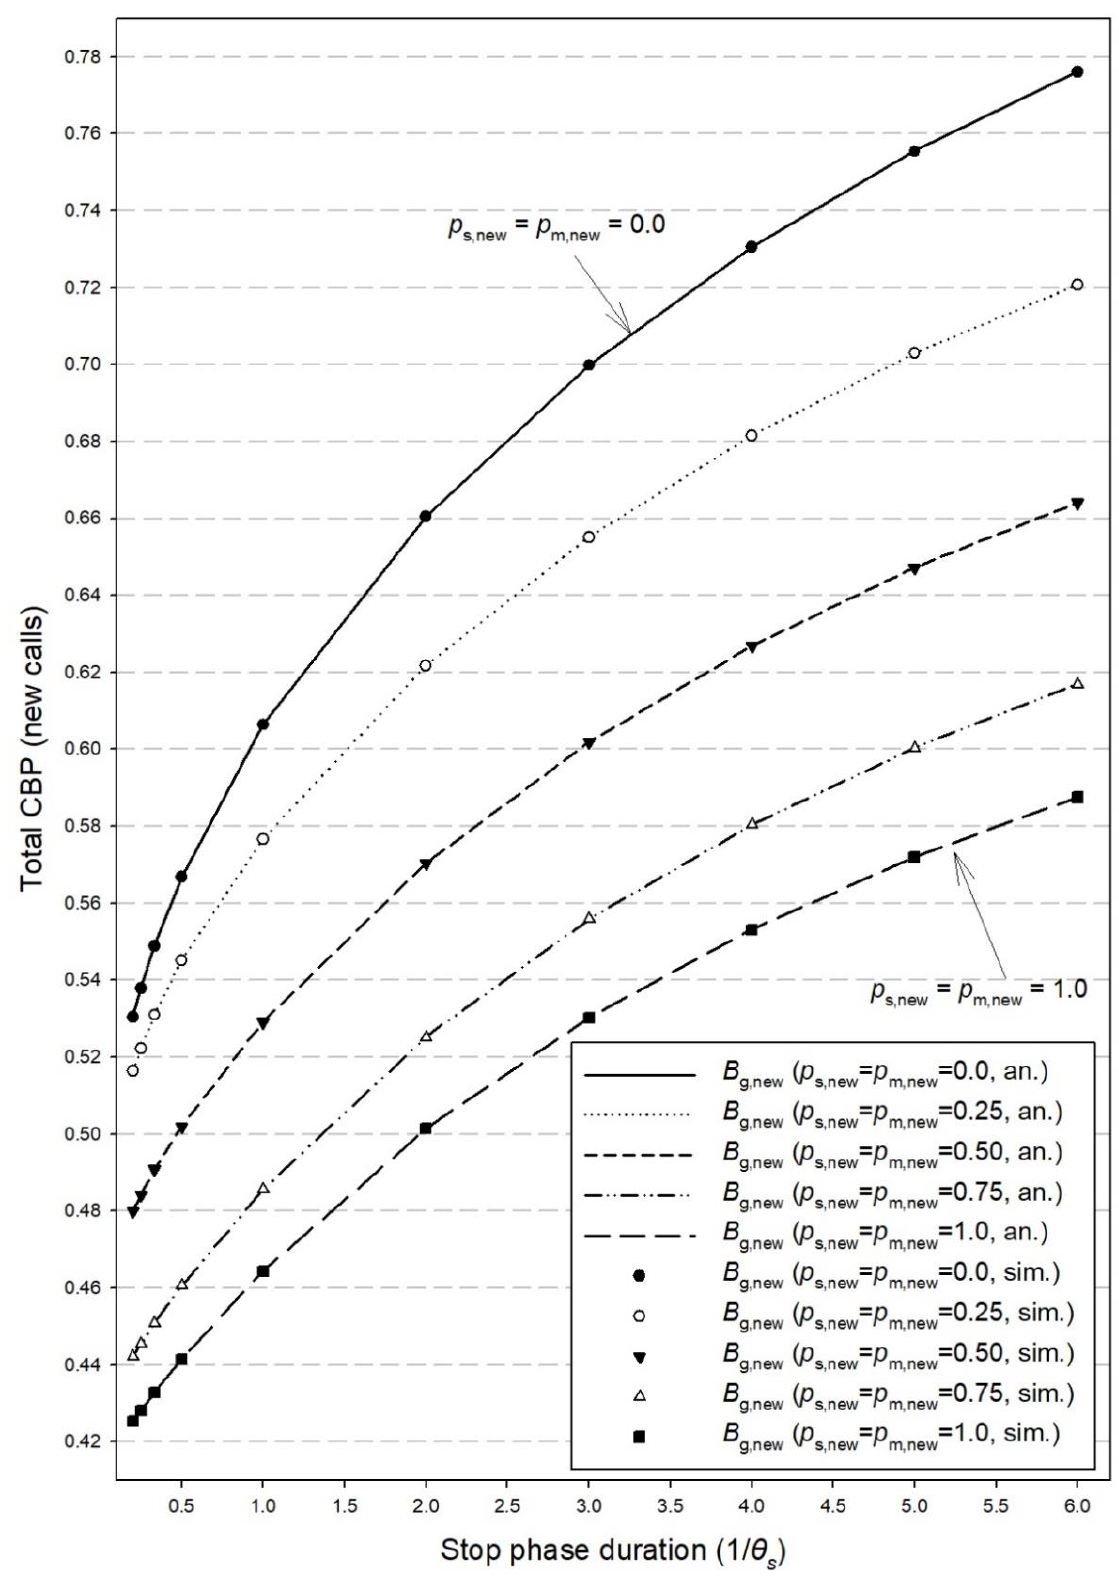
Figure 6. Total CBP of new calls for different values